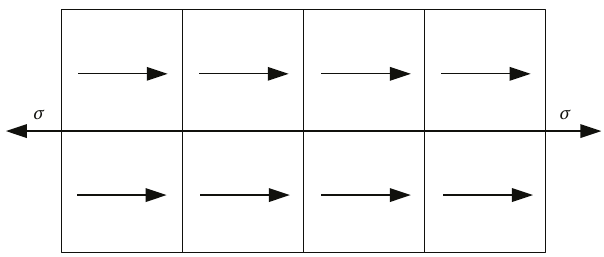
Figure 2: Direction of magnetic moment of ferromagnetic material under tensile